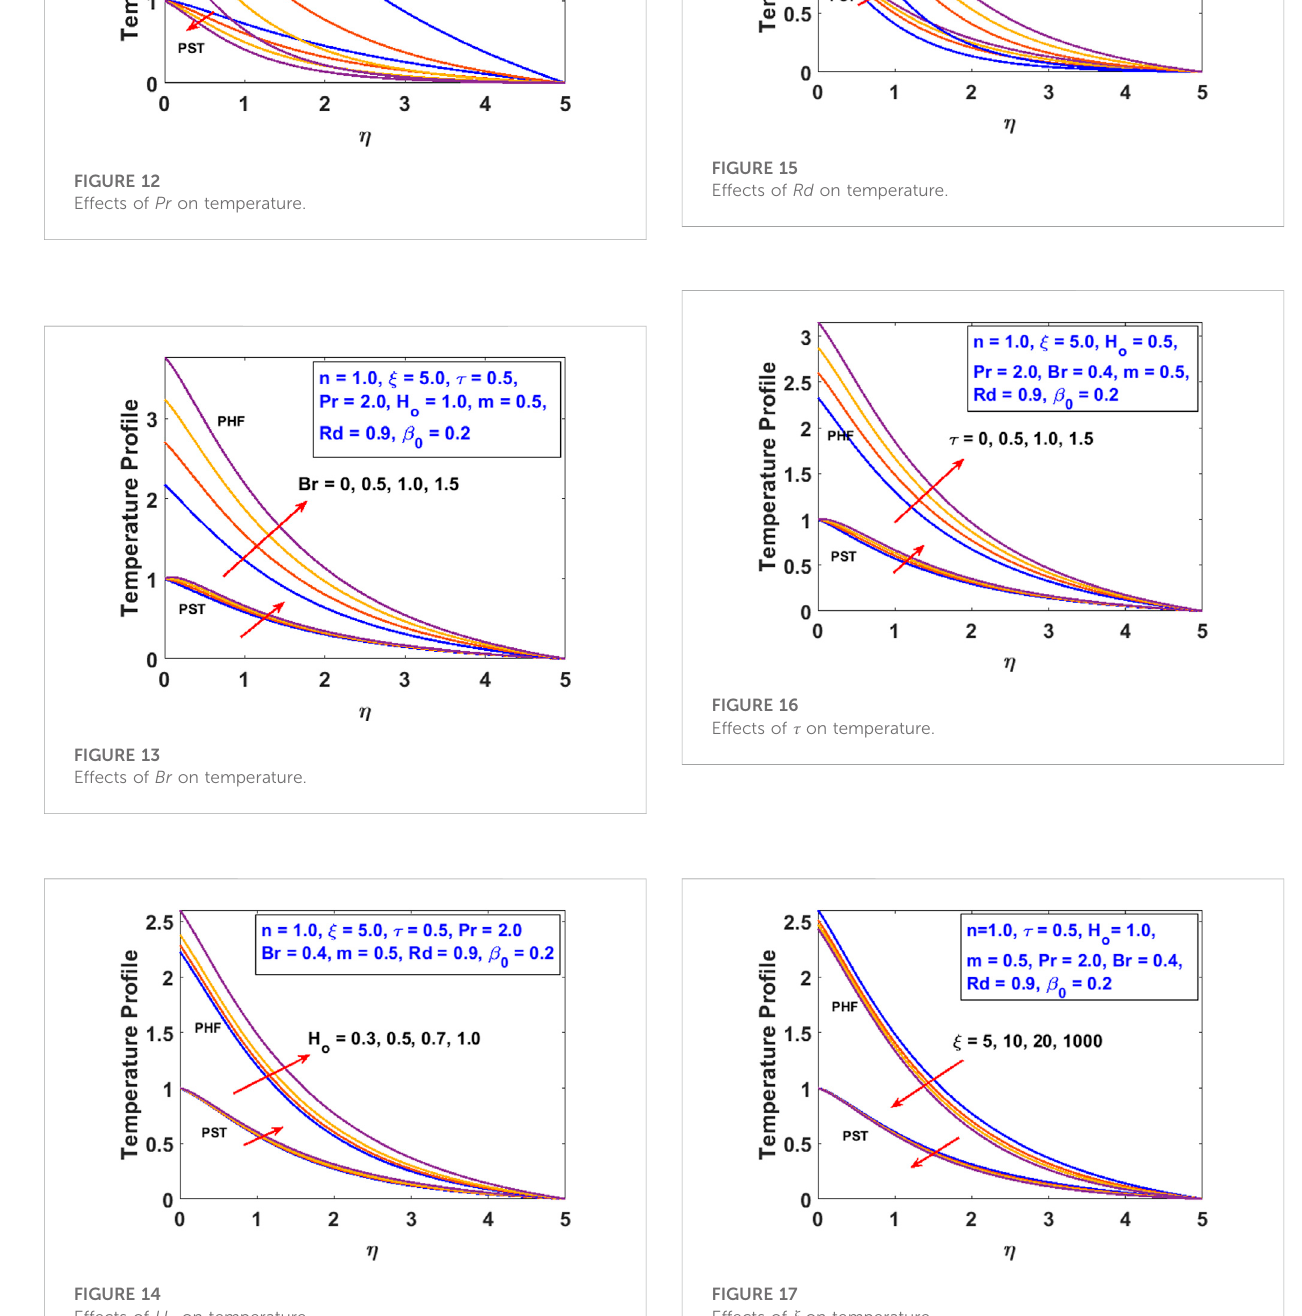
FIGURE 14 Effects of H o on temperature.